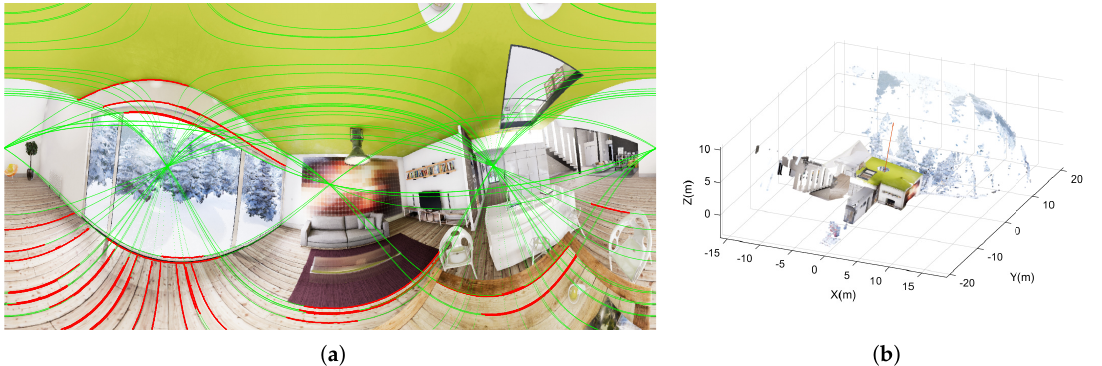
Figure 14. ( a ) Extracted line projections and segments on the non-central panorama. ( b ) Ground-truth point-cloud obtained from depth-map.